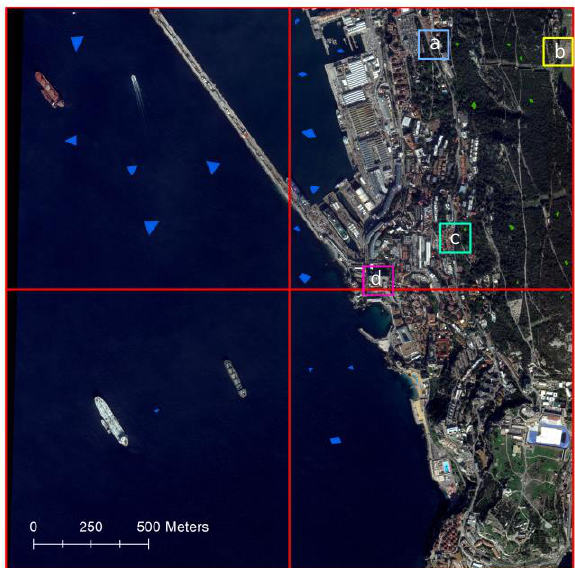
Figure 3. MAXAR image of Gibraltar test site, the tiles used for classification, test data polygons and location. The tile numbers are: tile-0 (top left), tile-1 (top right), tile-2 (bottom left), tile-3 (bottom